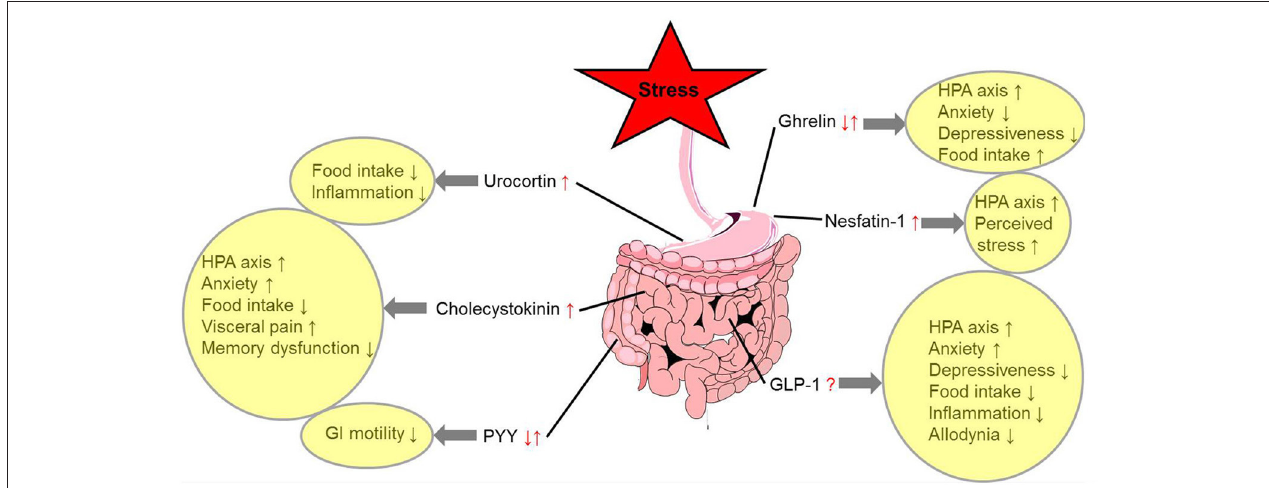
FIGURE 1 | Alterations of gut-brain peptides under conditions of stress and functional implications. ↓ , decrease; ↑ , increase; ?, unknown effect; GLP-1, glucagon-like peptide 1; GI, gastrointestinal; HPA axis, hypothalamus-pituitary-adrenal axis; PYY, peptide YY.